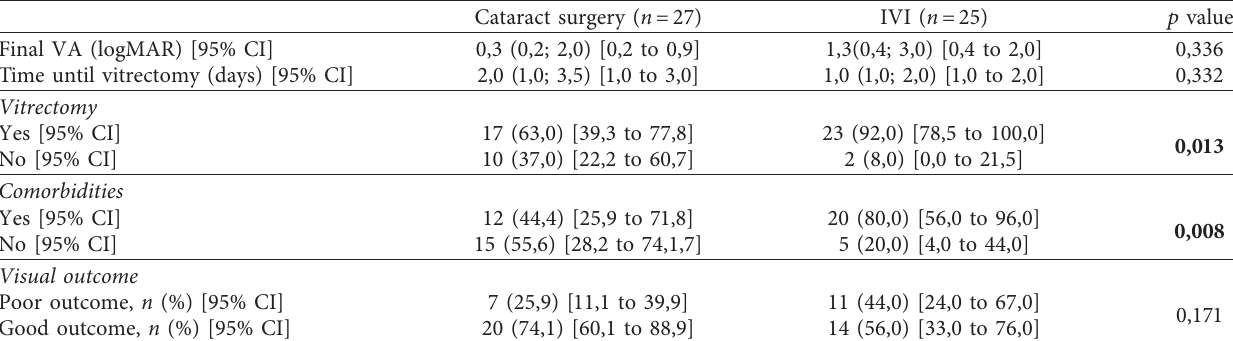
14 (56,0) [33,0 to 76,0]